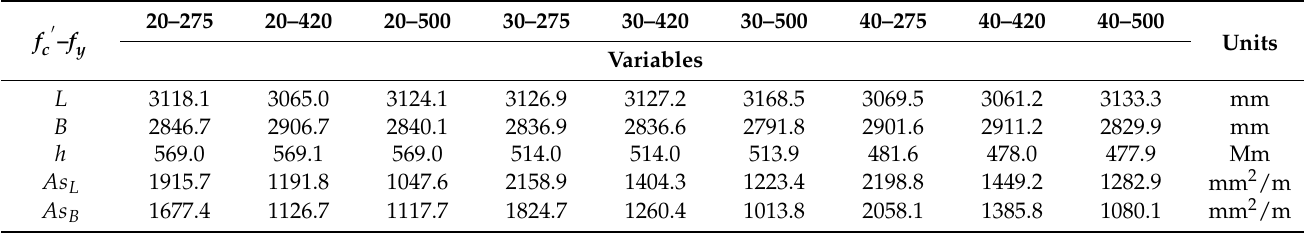
Table 11. Variables obtained for example 1 by varying material strength